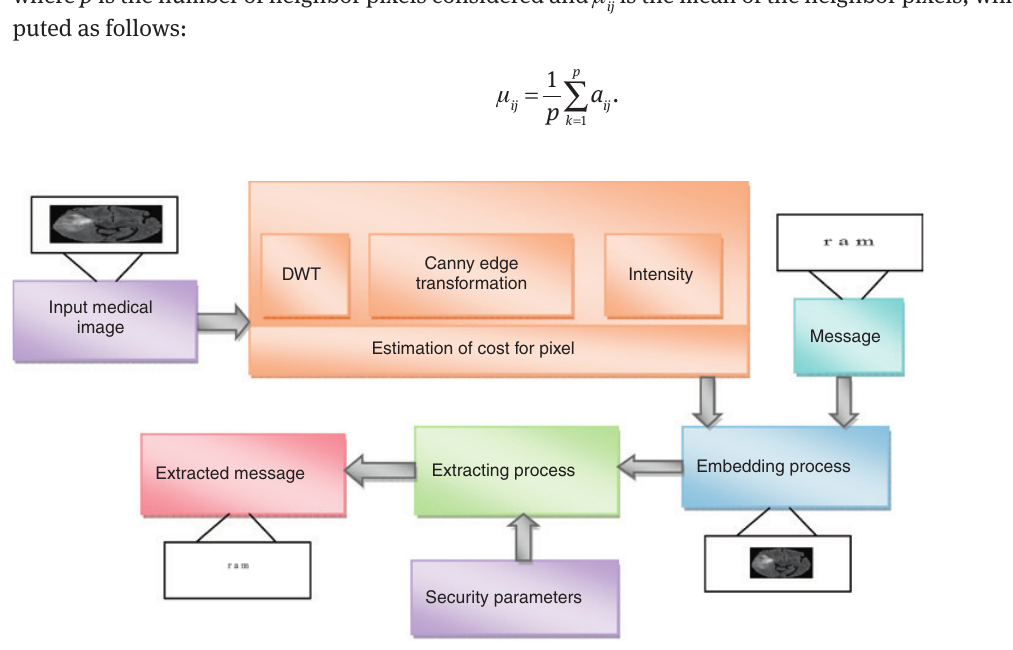
Figure 1: Block Diagram of the Proposed